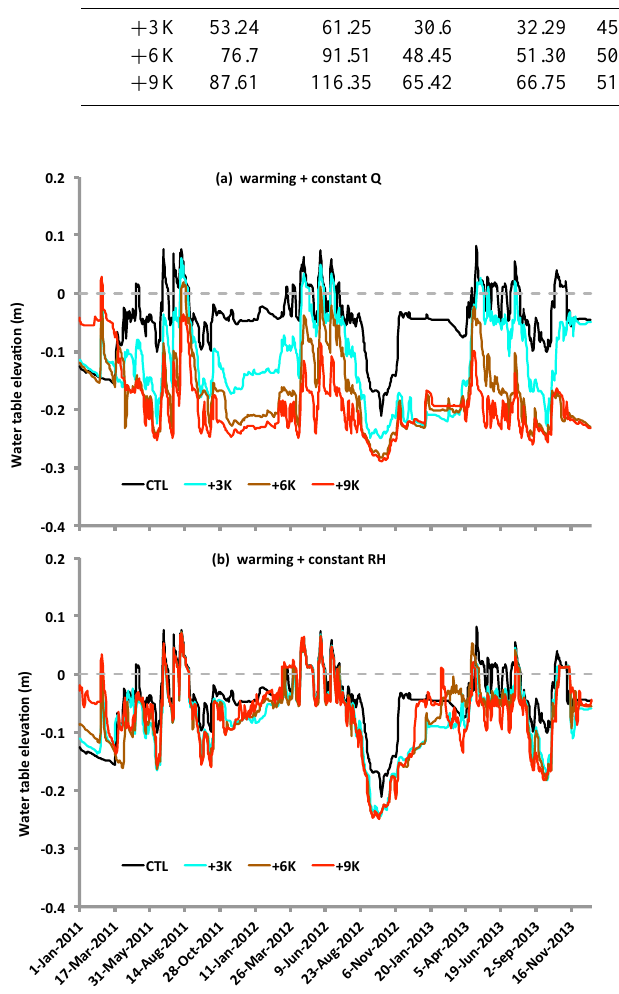
Figure 5. The simulated water table levels for years 2011–2013 for control (ambient) and warming scenarios ( + 3, + 6 and + 9K above ambient) based on two humidity conditions: (a) the same specific humidity for all four simulations (constant Q ); and (b) the same relative humidity for all four simulations (constant RH). Zero line indicates the surface of the hollow.